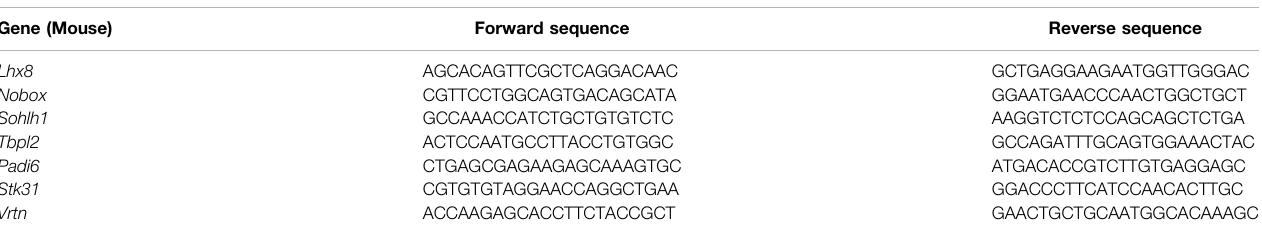
TABLE 2 | Primers used for qPCR